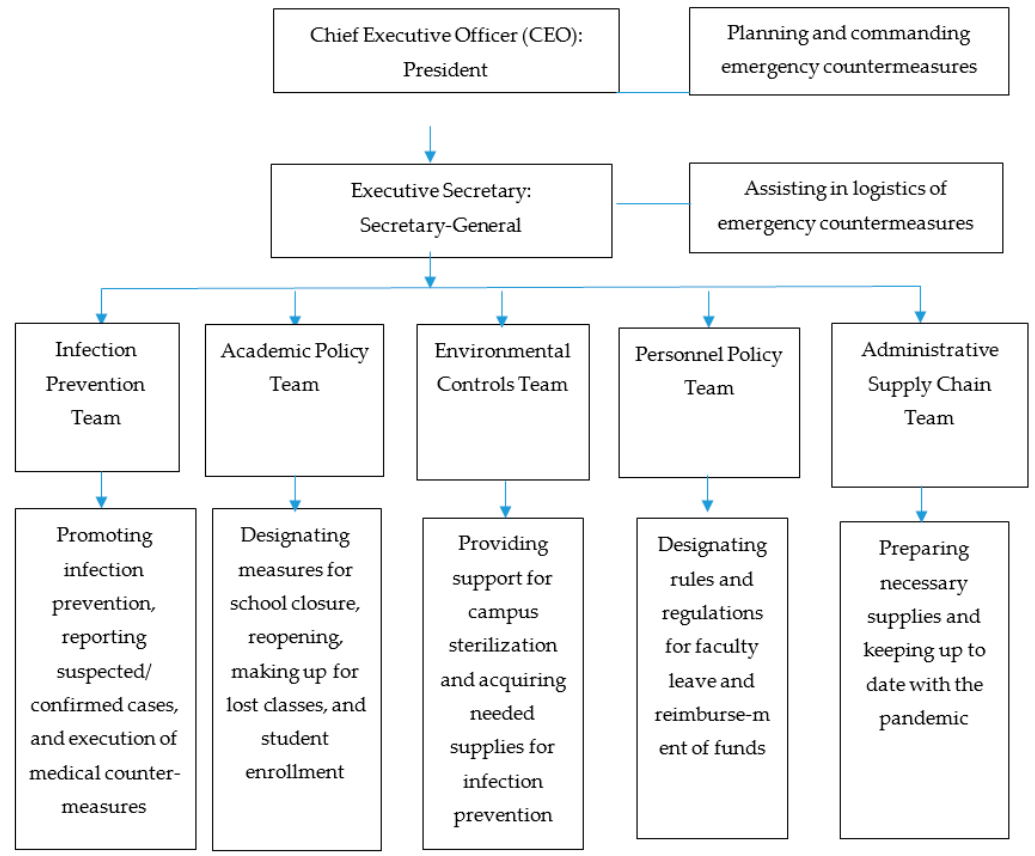
Figure 1. Organization of interdepartmental task force team in a college.